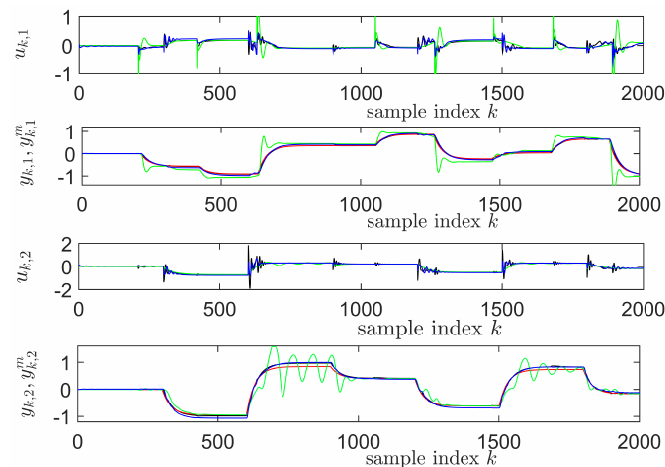
Figure 7. The IMF-AVI convergence on TITOAS: y m (black), for NP-IMF-AVI with NNs (blue), for the initial VRFT controller used for transitions collection (green) ( c (cid:13) 2019 IEEE [12]).